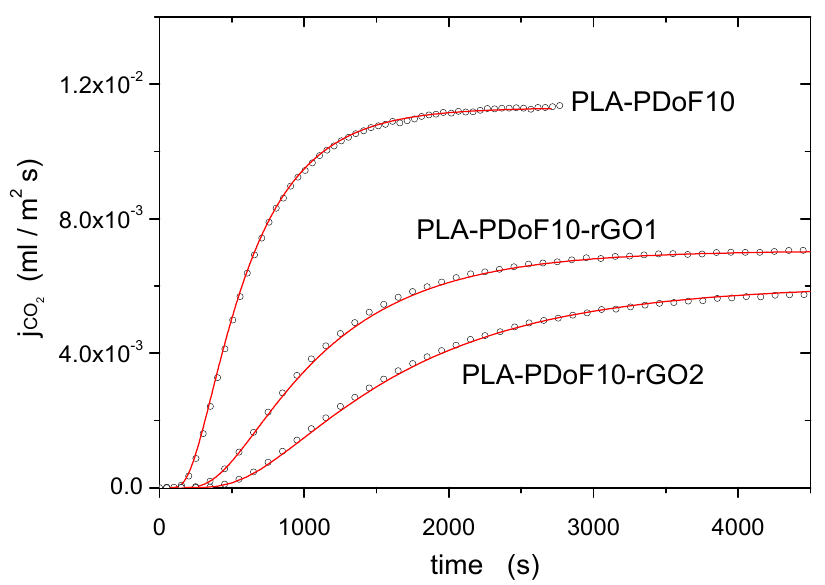
Figure 9. Representative trends of gas permeation flux j p ( t ) for CO 2 obtained on the samples PLA-PDoF10, PLA-PDoF10-rGO1 and PLA-PDoF10-rGO2 ( T = 298 ± 1 K, p feed = (45 ± 1) × 10 3 Pa). Experimental data: open symbols. Fitting equation: solid line.